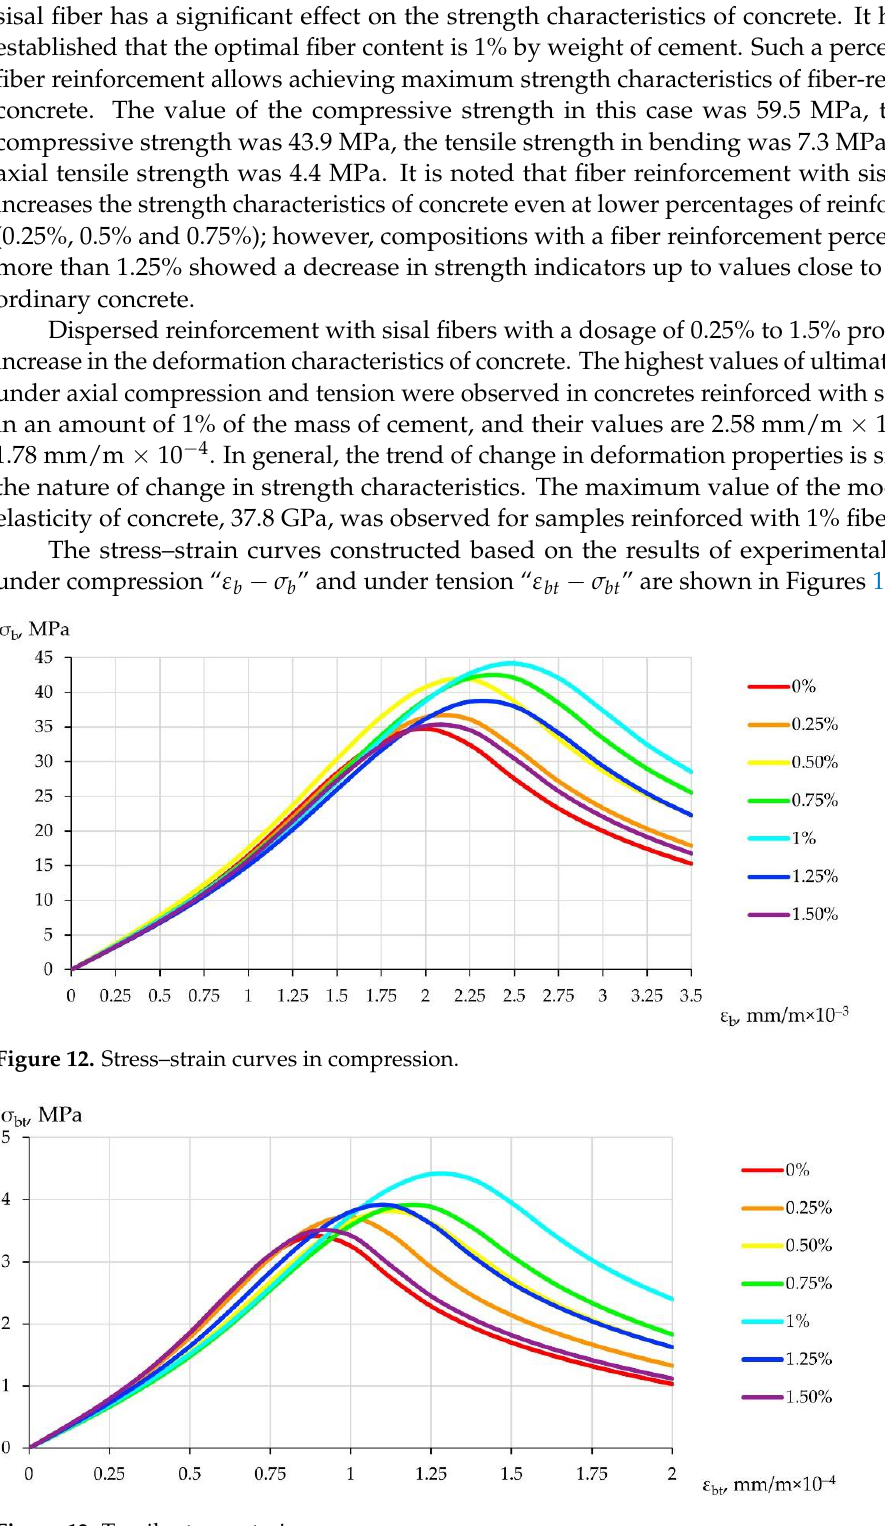
Figure 13. Tensile stress – strain curves.